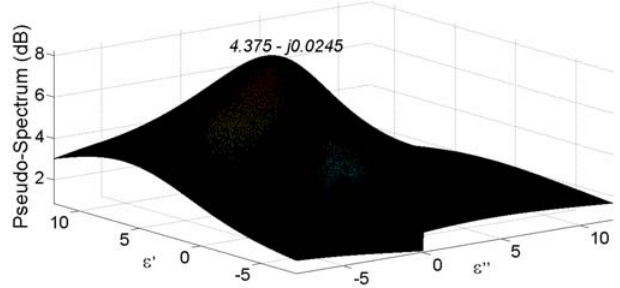
Figure 3: Pseudo-spectrum of FR-4 sample at 801 frequencies, frequency range 4.0 GHz and thickness 10 mm.